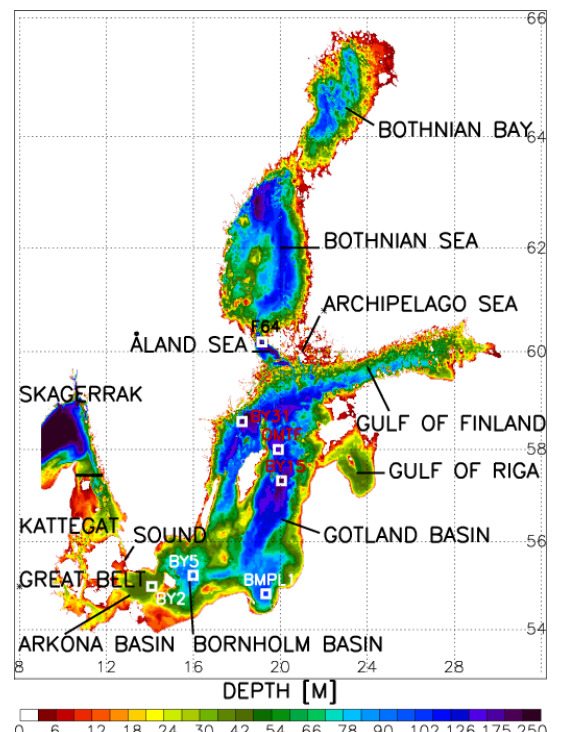
Figure 2. The bottom topography of the Baltic Sea and the locations of the monitoring stations of Arkona Deep (BY2), Bornholm Deep (BY5), Gda´nsk Deep (BMPL1), Gotland Deep (BY15), Northern Deep (OMTF0286), Landsort Deep (BY31), and Åland Sea (F64). The Baltic proper comprises the Arkona Basin, Bornholm Basin, and Gotland Basin. Data source: Seifert and Kayser (1995); see https://www.io-warnemuende.de/ topography-of-the-baltic-sea.html (last access: 5 March